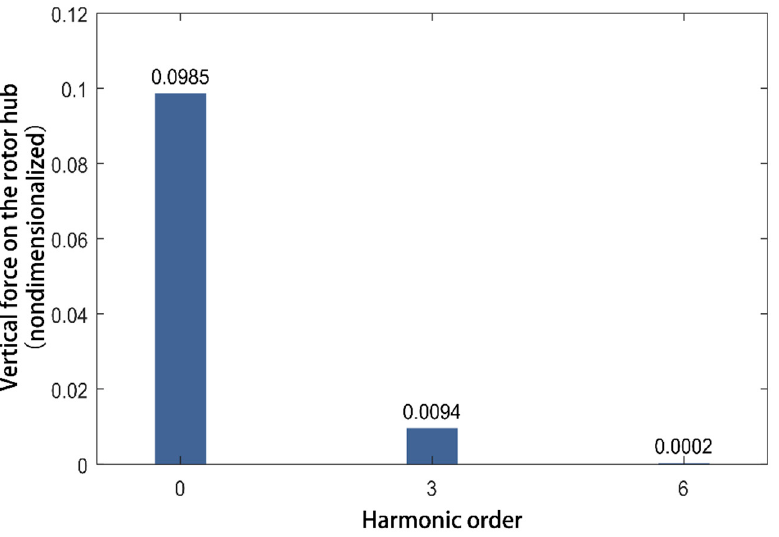
Figure 17. Vertical force on the rotor hub divided into harmonic components (nondimensionalized).